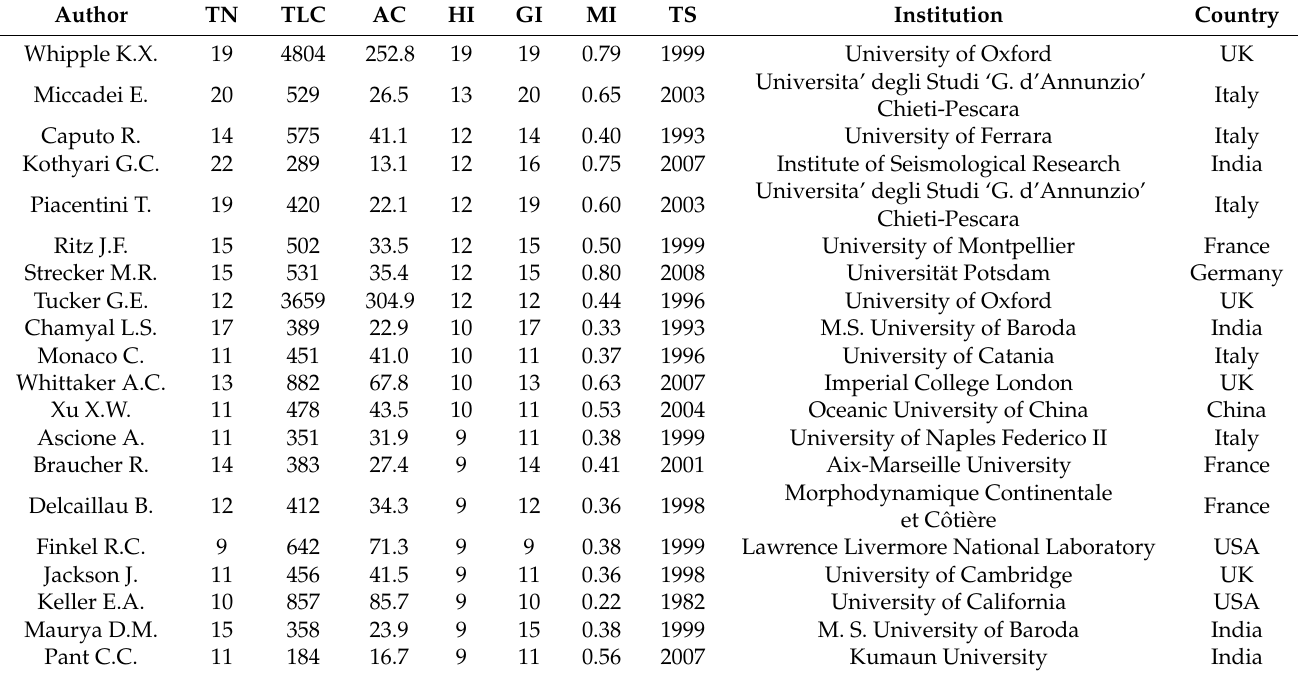
Table 4. Top 20 authors in tectonic geomorphology research in 1981–2021.